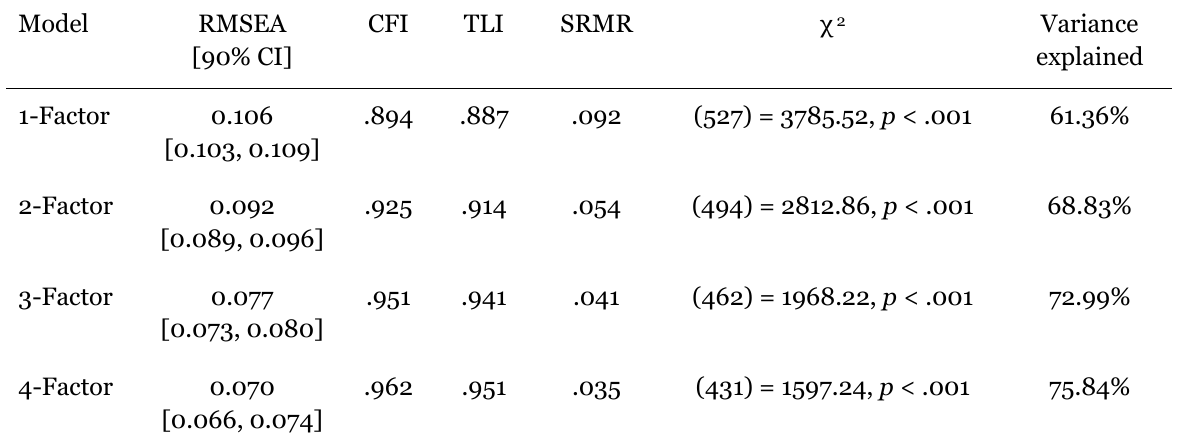
Fit Indices for the Four Exploratory Factor Analysis Models (N = 34 items) Model RMSEA CFI TLI SRMR χ 2 Variance [90% CI]